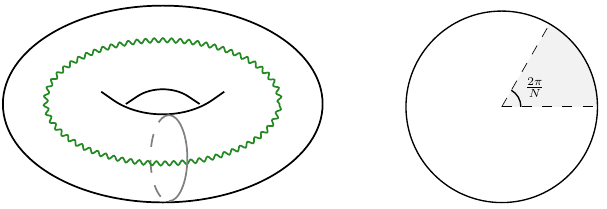
Figure 2. Left: the Euclidean geometry is asymptotically AdS in the interior (shown in green). Right: the orbifold singularity corresponds to a conical defect of 2 (cid:25) (1 (cid:0) 1 =N